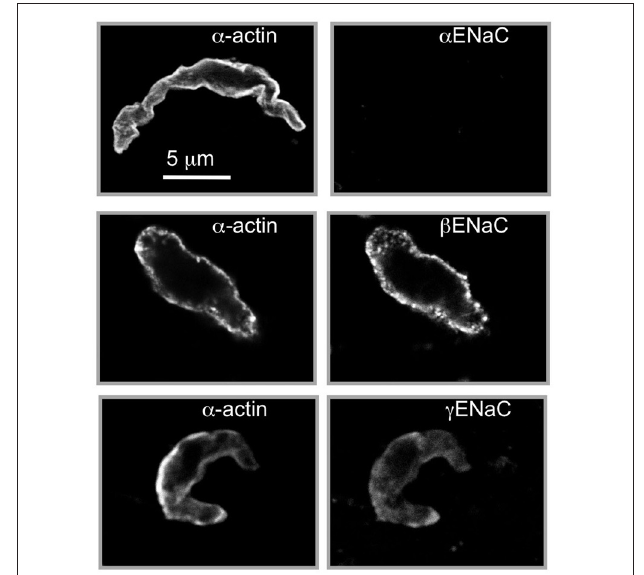
FIGURE 2 | Localization of β ENaC and γ ENaC in enzymatically dissociated renal VSMCs. VSMCs were identified by labeling with a smooth muscle actin (left column). We detected β ENaC and γ ENaC, but not α ENaC, at or near the VSMC surface. The strongest labeling is consistently observed for β ENaC. Scale bar represents 5 μ m. (Figure includes images reproduced from American Journal of Physiology, Renal Physiology 289; F891–F901, 2005, Figure